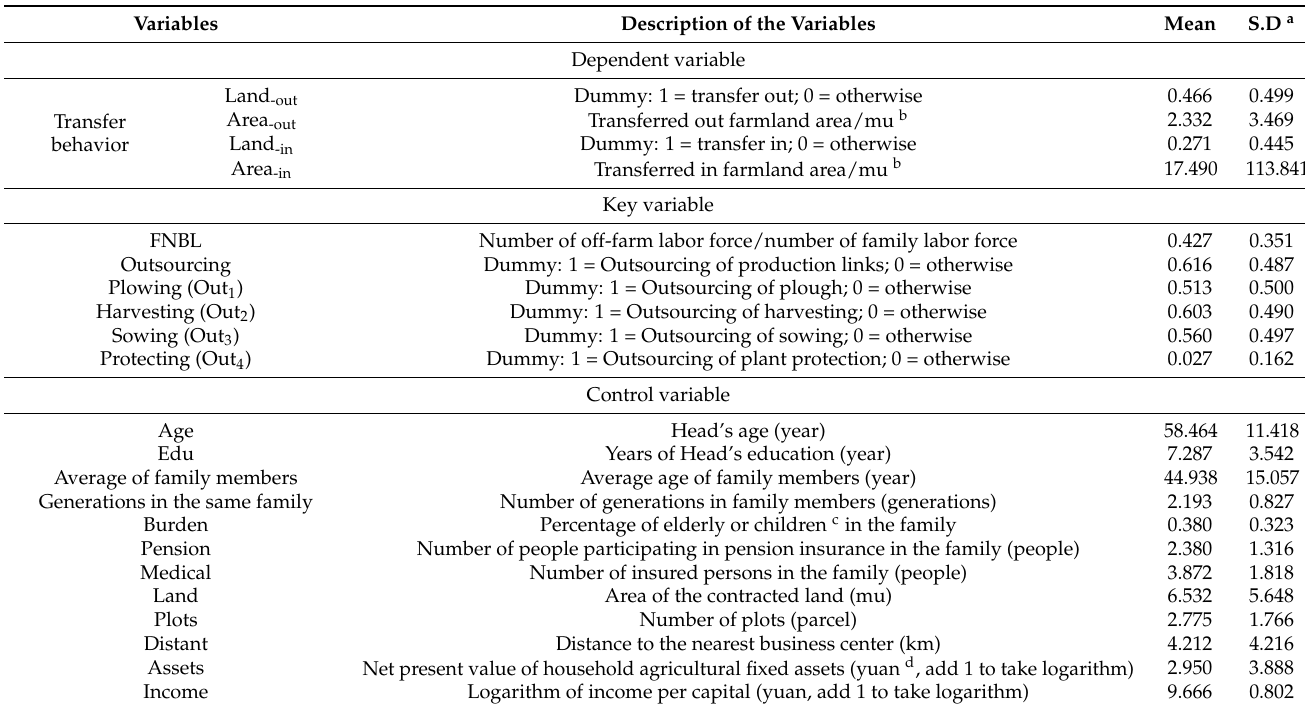
Table 1. Variables description and statistical